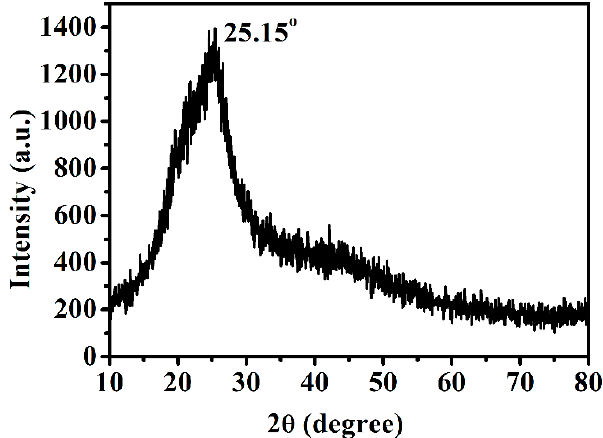
Figure 3. X-ray diffraction of g-CQDs (V (EDA) = 4 mL, T = 180 °C, D r = 12 h).